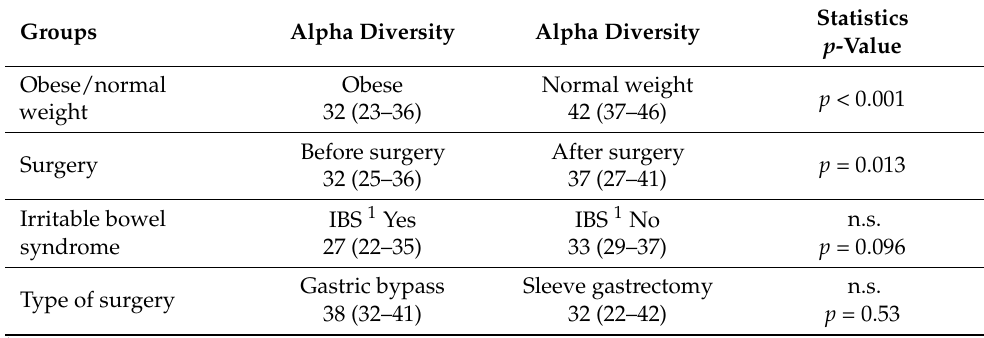
Table 3. Alpha diversity in groups of subjects reported as median and interquartile